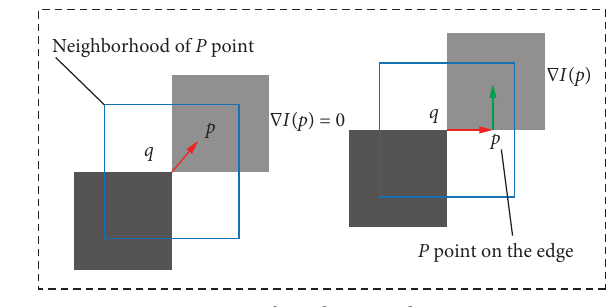
Figure 7: Subpixel corner